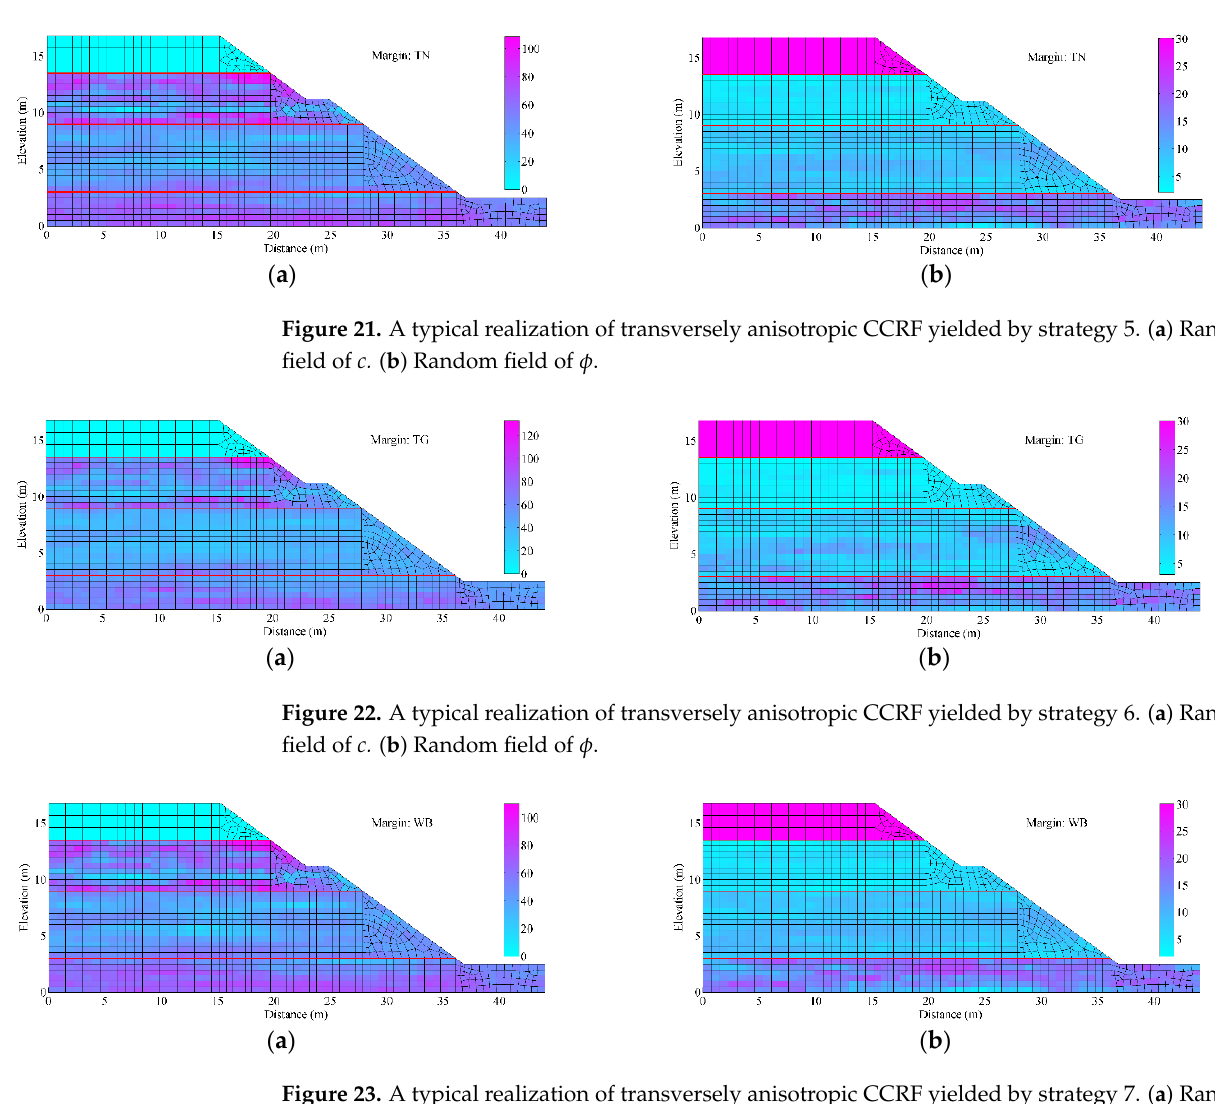
Figure 20. A typical realization of transversely anisotropic CCRF yielded by strategy 4. ( a ) Random field of c. ( b ) Random field of ϕ.